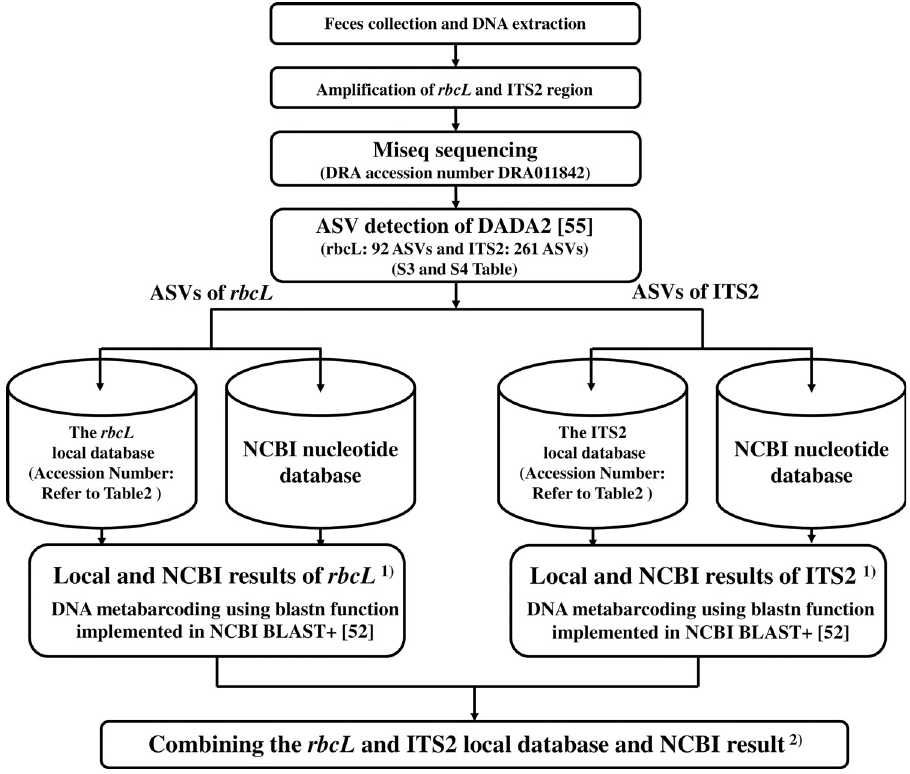
Fig 2. Flowchart of process used to identify food plant resources of Japanese rock ptarmigan in this study.